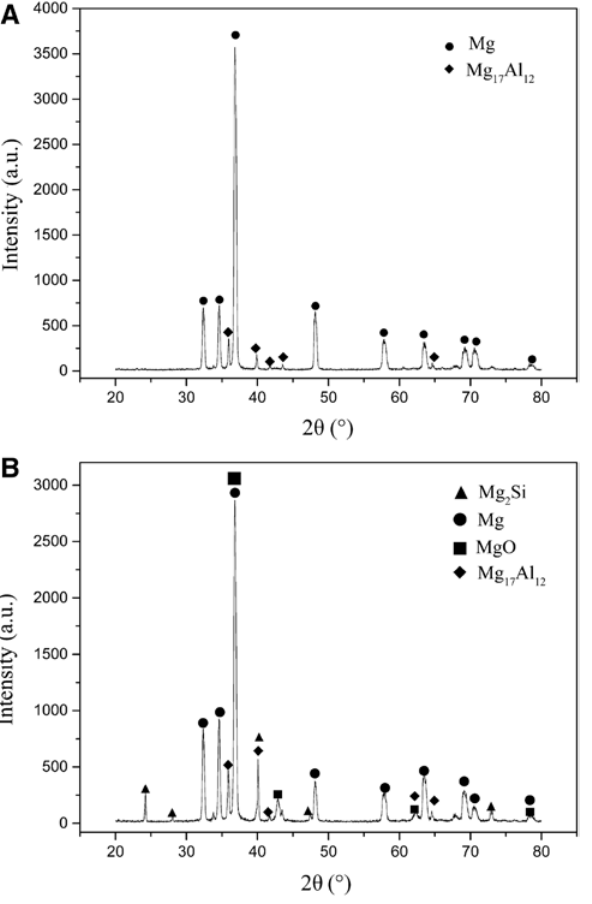
Figure 3: XRD patterns of (A) AZ91D Mg alloy and (B) 6 wt.% FAC/ AZ91D composites.